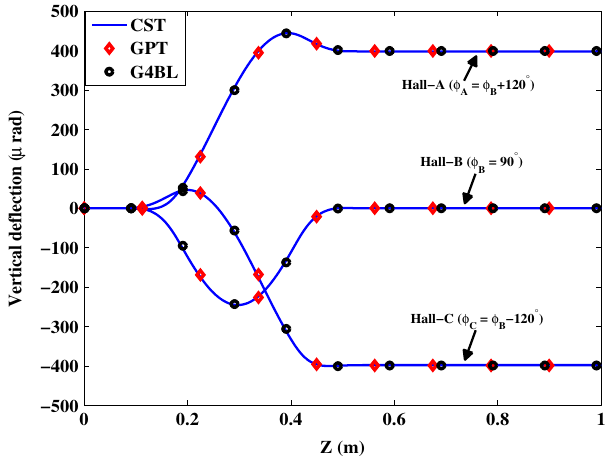
FIG. 7. Vertical deflection of an 11 GeV electron for rf phases (cid:4) (cid:4) (cid:4) A , B , and C of the superconducting cavity (see Fig. 2). Simulation results are compared using CST PARTICLE TRACKER , GPT , and G4BEAMLINE computer codes.